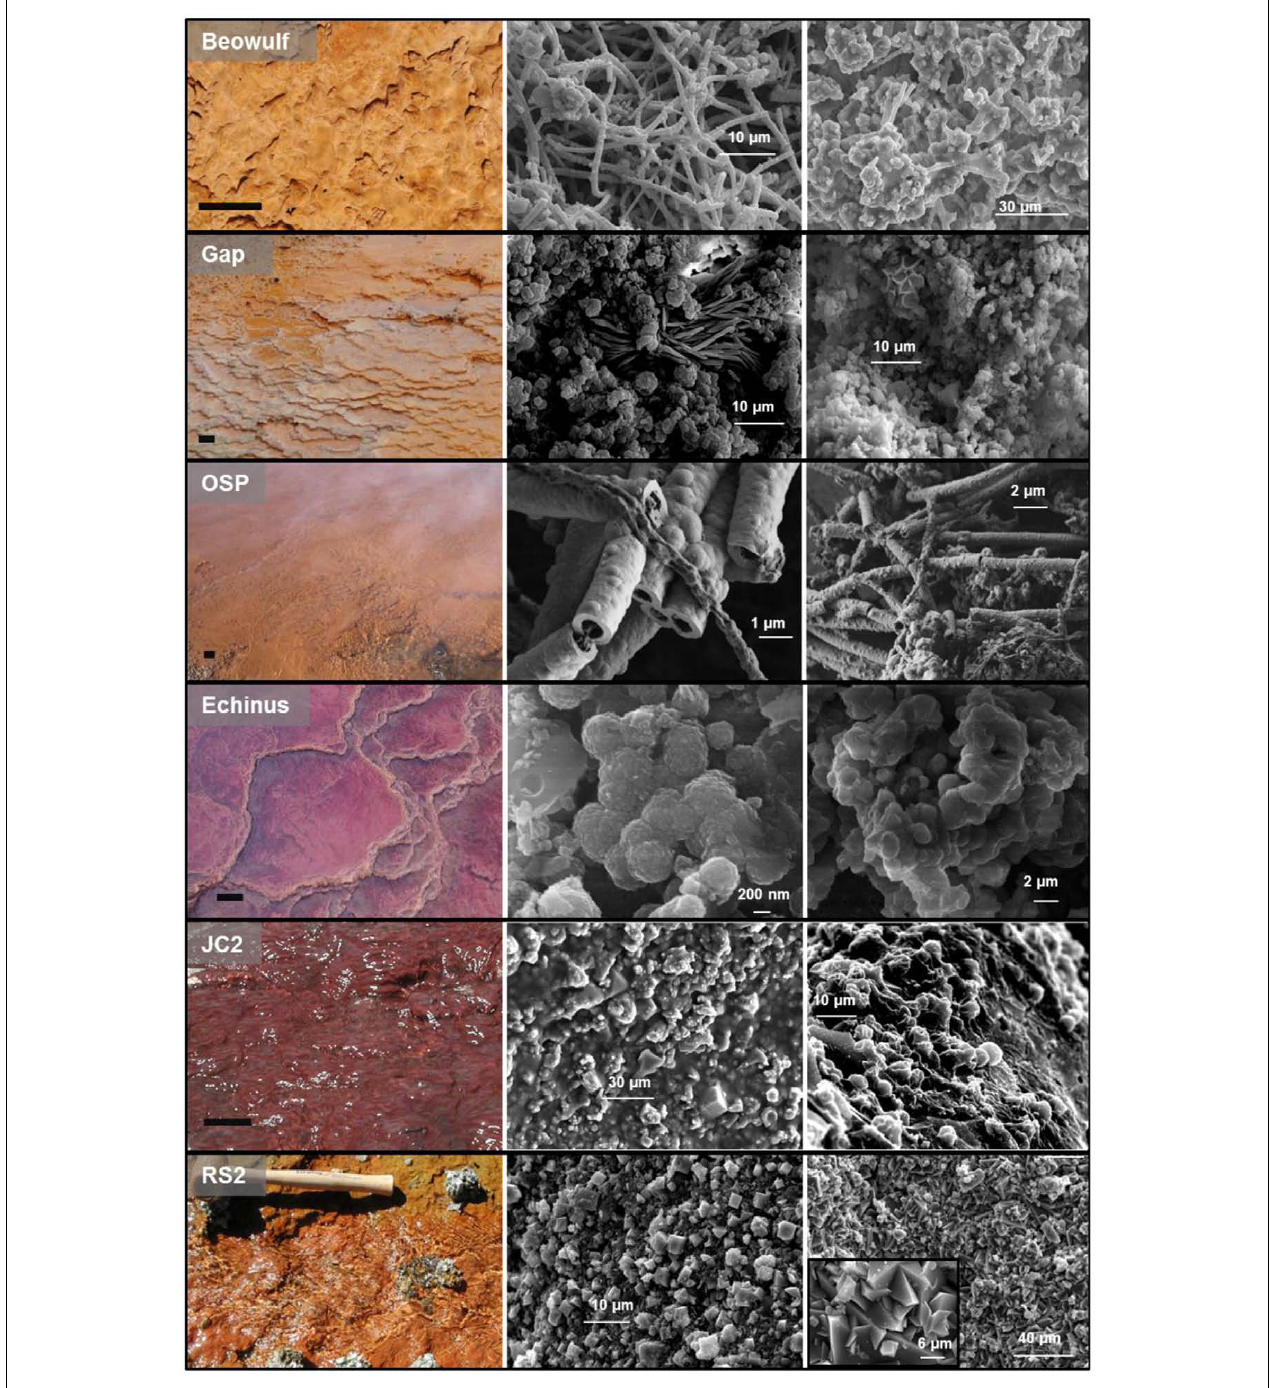
FIGURE 4 | Ferric iron phases from select ferric iron mats inYellowstone National Park with corresponding scanning electron micrographs of solid phases found within each spring (results also presented inTable 1). Scale bar on site photographs is ∼ 5cm.